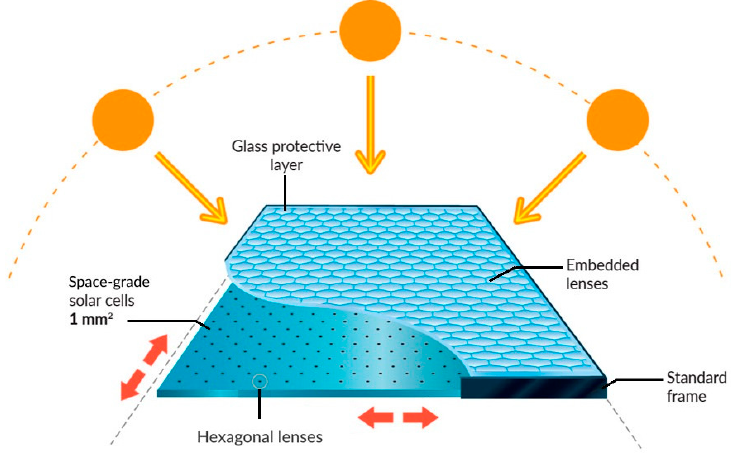
Figure 1. Optical micro-tracking technology of HIPERION panel (http://www.hiperion-project.eu/, accessed on 6 March 2023).